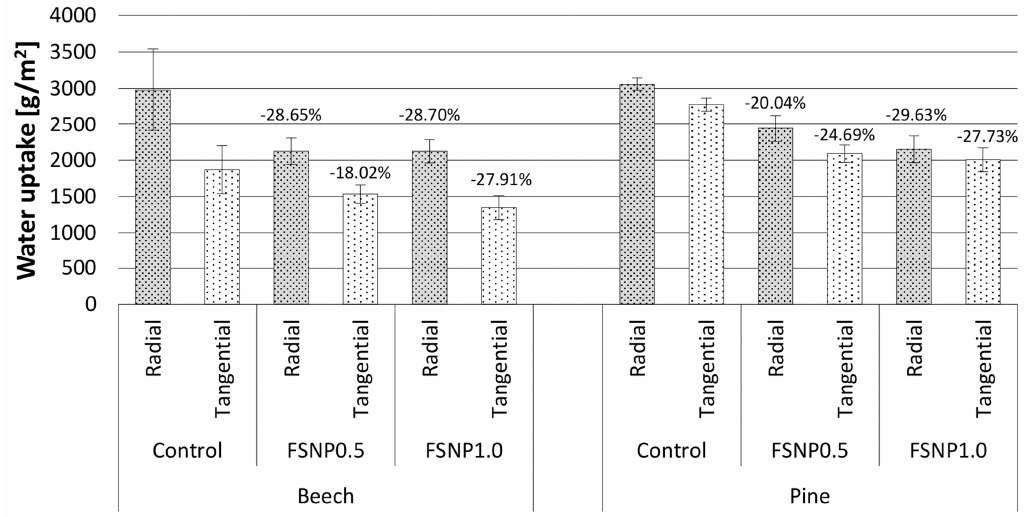
Figure 9. Water uptake of FSNP-treated and untreated beech and Scots pine wood in radial and tangential directions (percentages show the difference to the control and whiskers the standard deviation of the results).